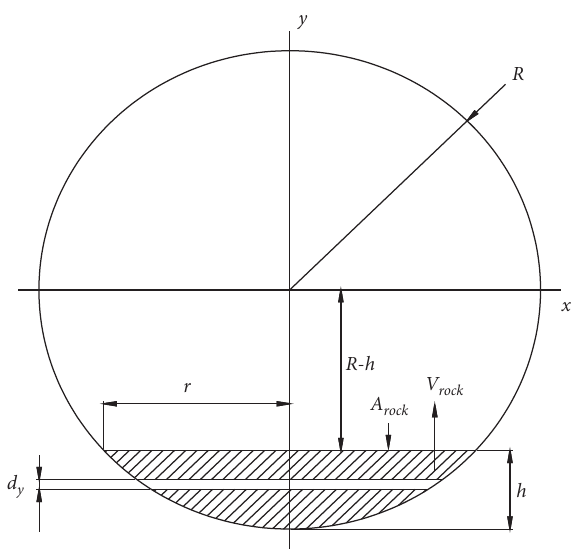
Figure 7: Diagram approximating the drilled volume in a rock fractured by a